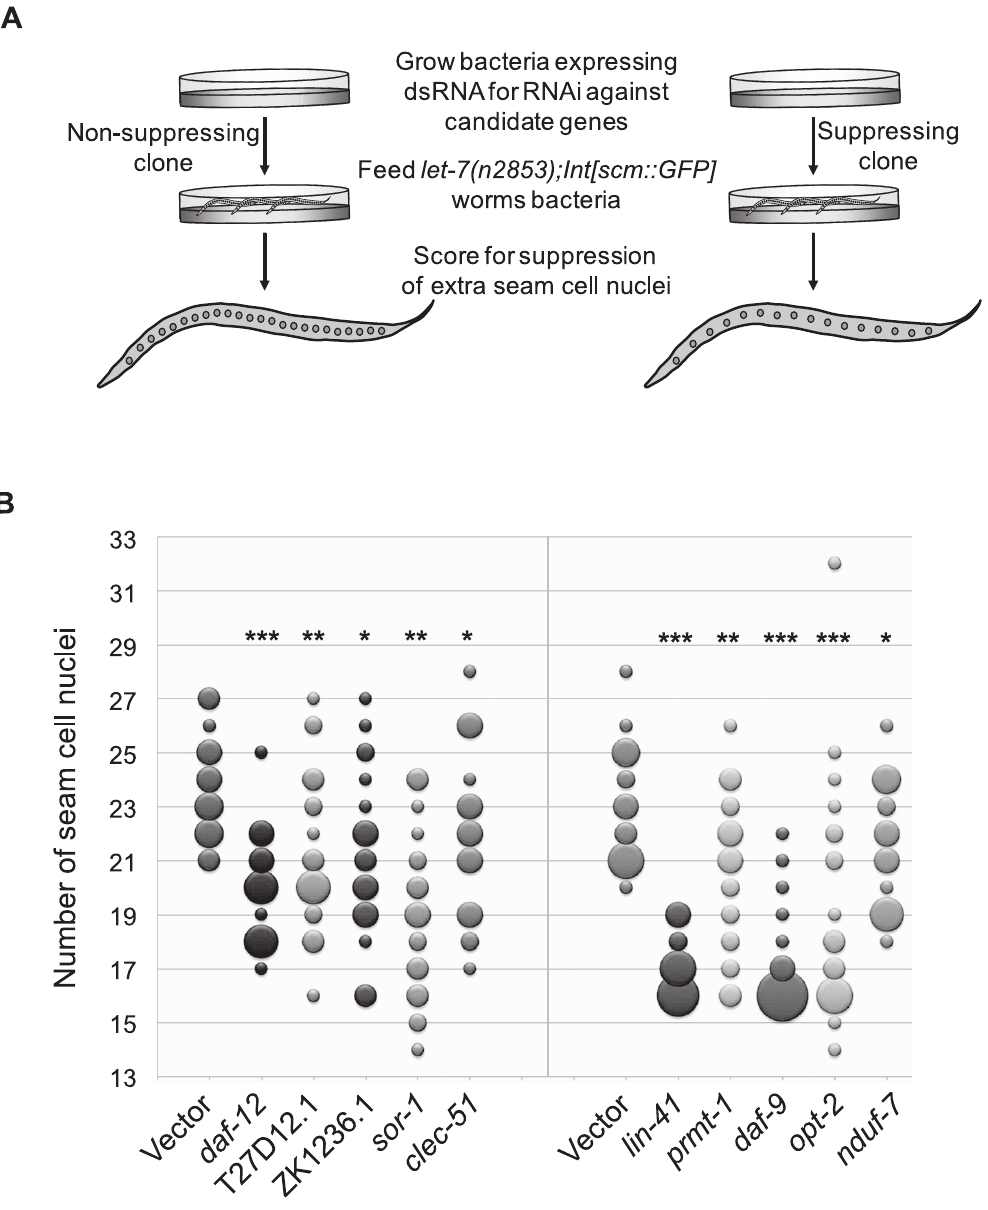
Figure 3. Suppression of supernumerary seam cell nuclei in let-7 mutants. (A) While wild-type worms have 16 seam cell nuclei, let-7(n2853) worms have significantly more ( , 23) [82]. To score for suppression of the extra seam cell phenotype, let-7 mutants expressing nuclear GFP in seam cells ( let-7(n2853) ; Int[scm::GFP] ) were grown at the restrictive temperature (25 6 C) on bacteria expressing dsRNA against candidate targets and the vector control. The number of seam cell nuclei was counted in a population of 20 worms evaluated against the same size population concurrently grown on the empty vector control. RNAi clones that resulted in worm populations with significantly lower seam cell numbers (p , 0.05) were retested and scored using a population of at least 20 worms. (B) Suppressors of the extra seam cell nuclei phenotype in let-7(n2853) (p-value , 0.05) are shown by bubble plot. Each bubble indicates the number of seam cell nuclei per worm for a population (n $ 20) and the size of each bubble is proportional to the number of the animals in the population with a given seam cell number. * p , 0.05, ** p , 0.01, *** p , 0.0001 in two independent trials.